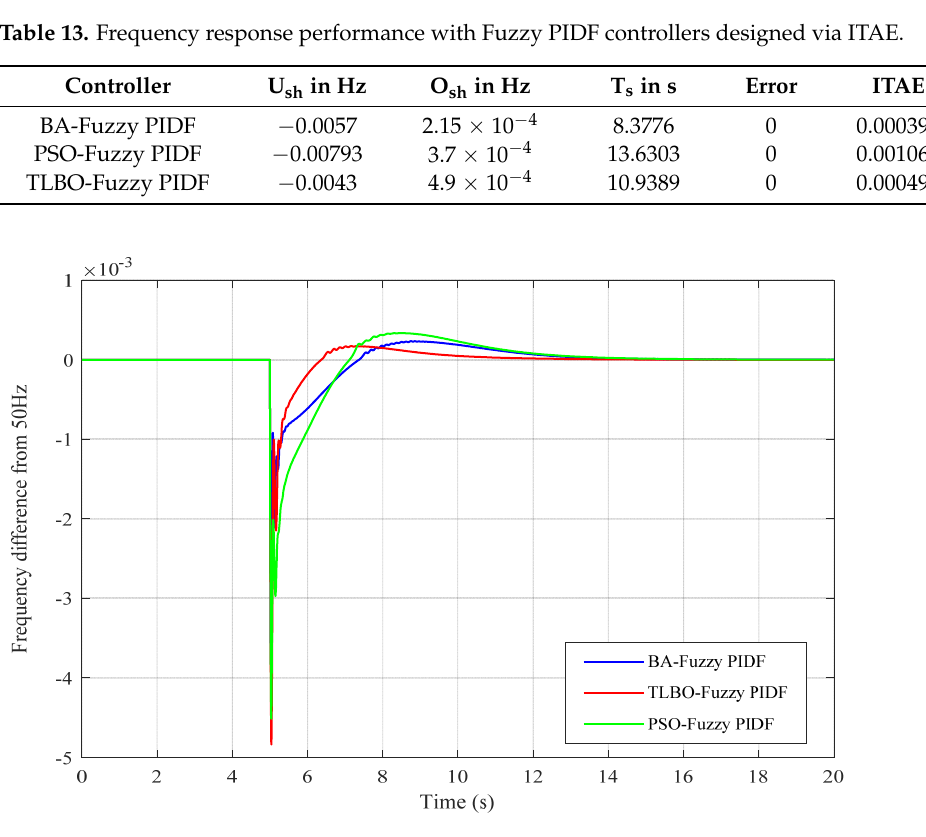
Figure 10. Change in frequency in the GB power system for 0.035 pu load disturbance with tuned Fuzzy PIDF-based ISE.